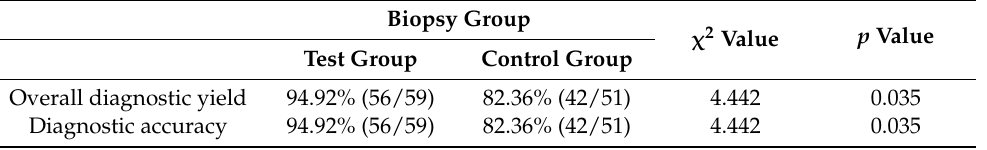
Table 3. Comparison of the diagnostic performance between the test and control